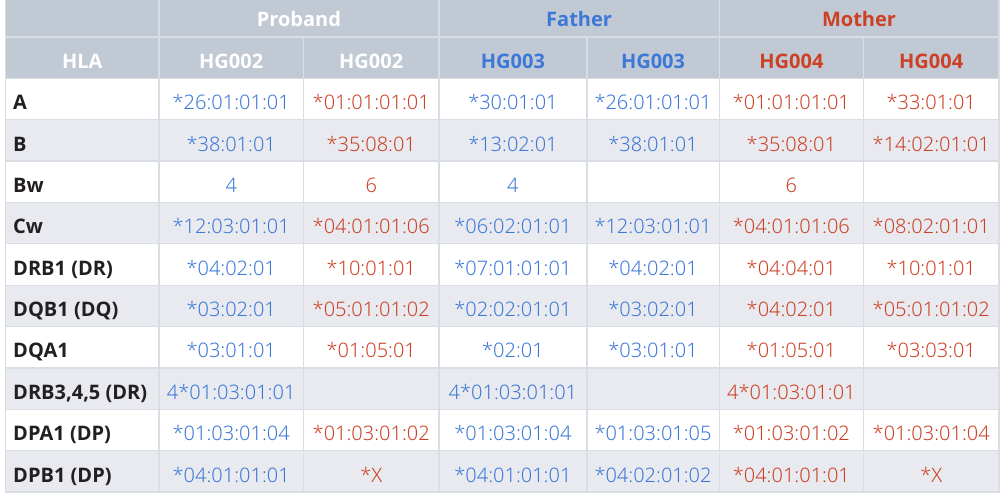
Table 1. Genotyping results for proband HG002 and parents HG003 and